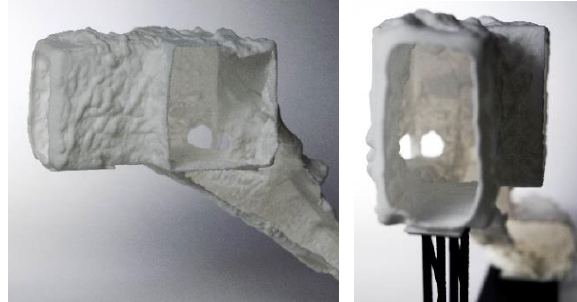
Figure 16 and 17: Model of the tomb of Ipi. Access view.